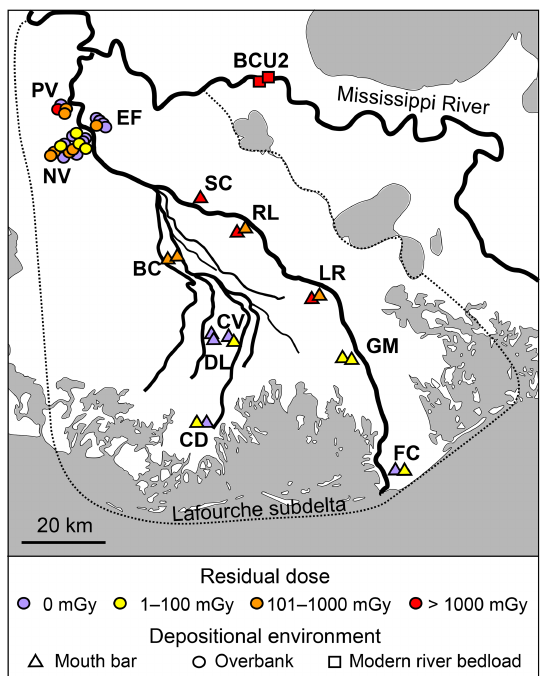
Figure 8. Geographic distribution of sands and their minimum residual doses, defined as the residual dose minus its uncertainty.